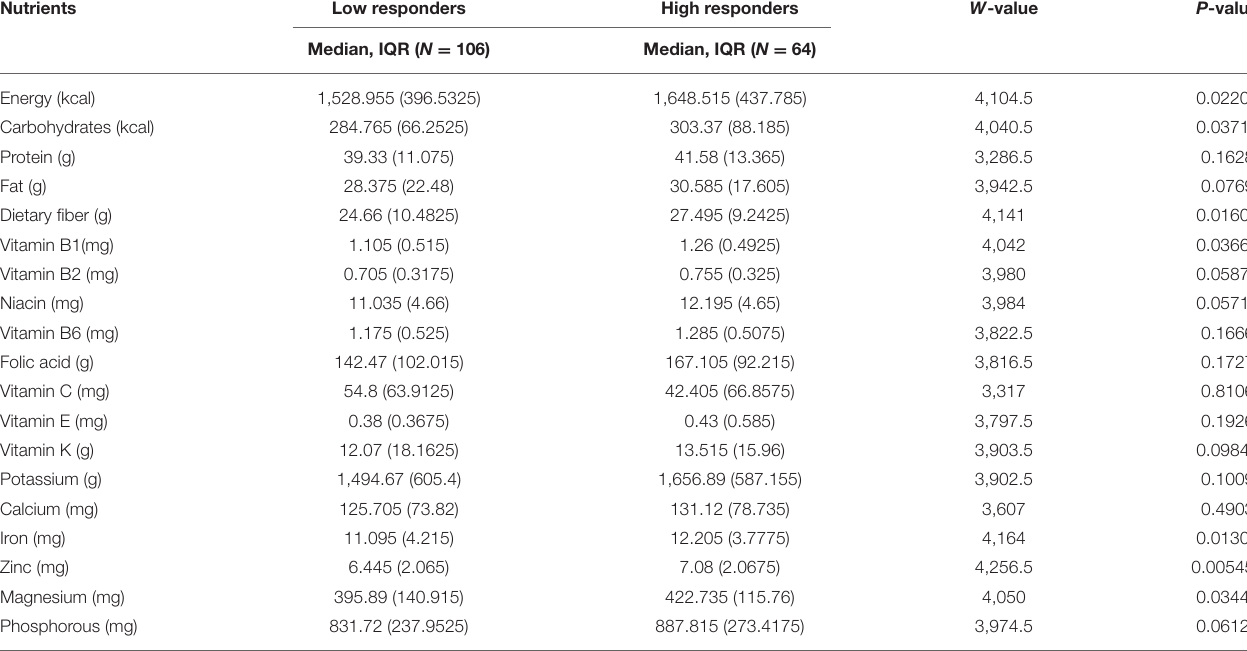
TABLE 5 | Mann-Whitney U statistical analysis of PCV-10 vaccination response and dietary intake.